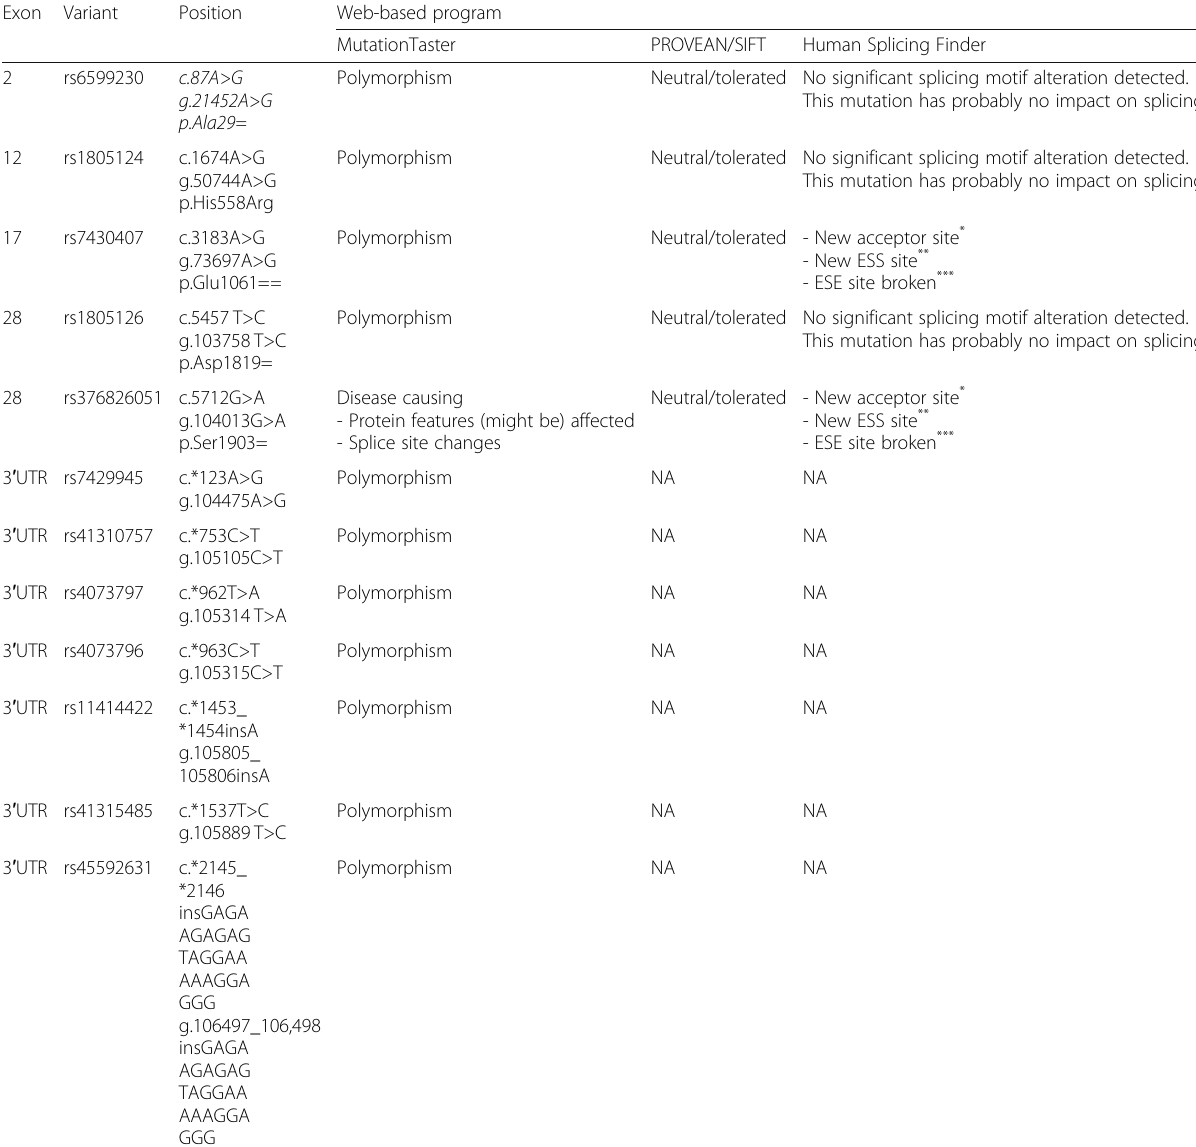
Table 3 Prediction results of 12 variants of SCN5A obtained from SUNDS by three online prediction programs (MutationTaster, PROVEAN/SIFT, Human Splicing